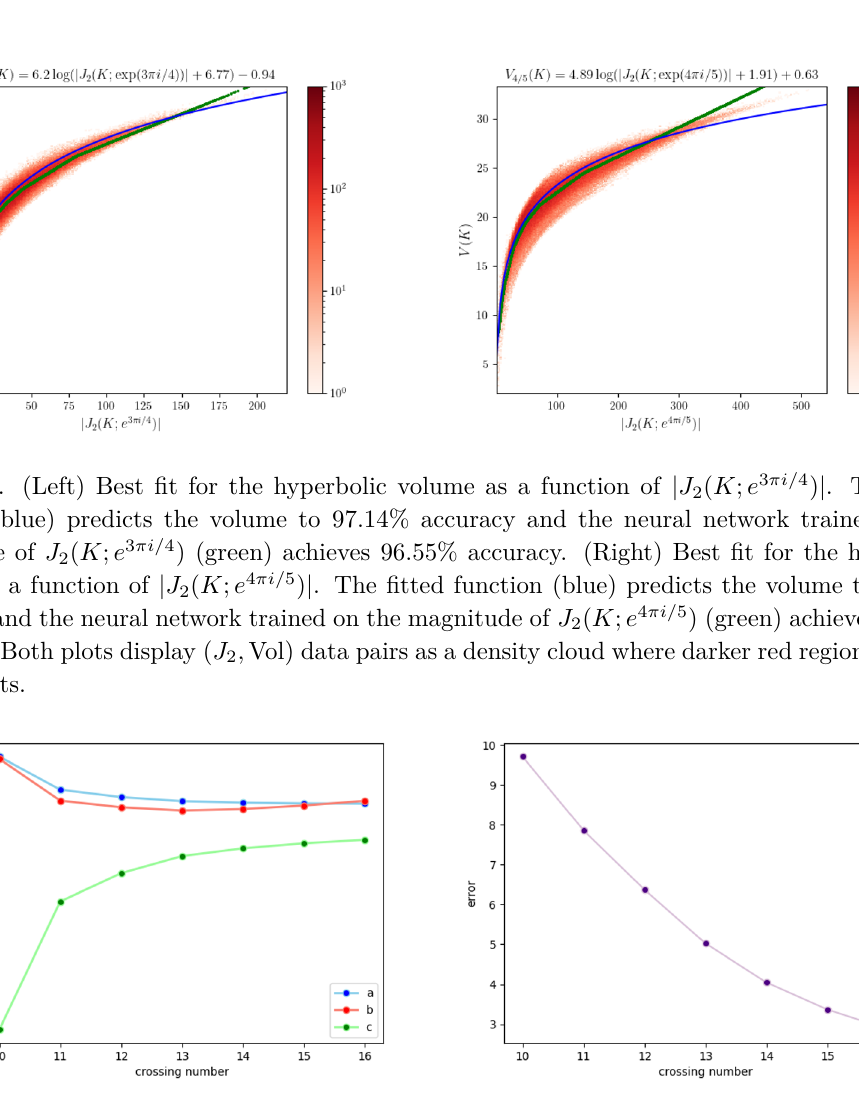
Figure 5 . Variation of fit parameters with regression data. As more regression data is included, the fit parameters converge to some constant values. This indicates that the approximation formulas should perform well outside of our